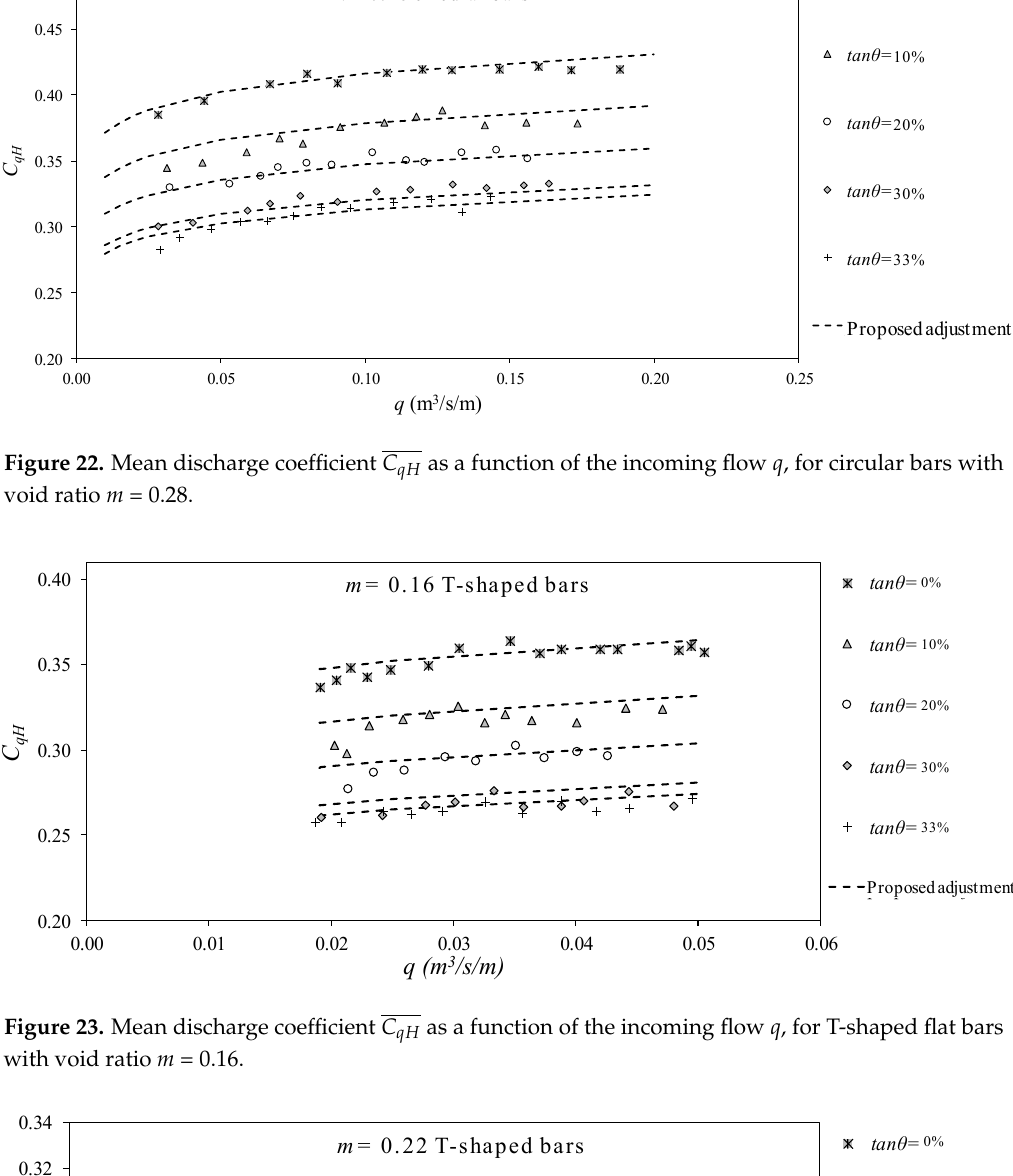
Figure 21. Mean discharge coefficient as a function of the incoming flow q , for circular bars with void ratio m = 0.60.